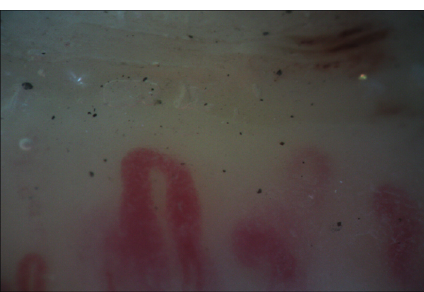
Figure 3: A nailfold capillaroscopy that shows alterations indi- cating a “scleroderma-like pattern.”